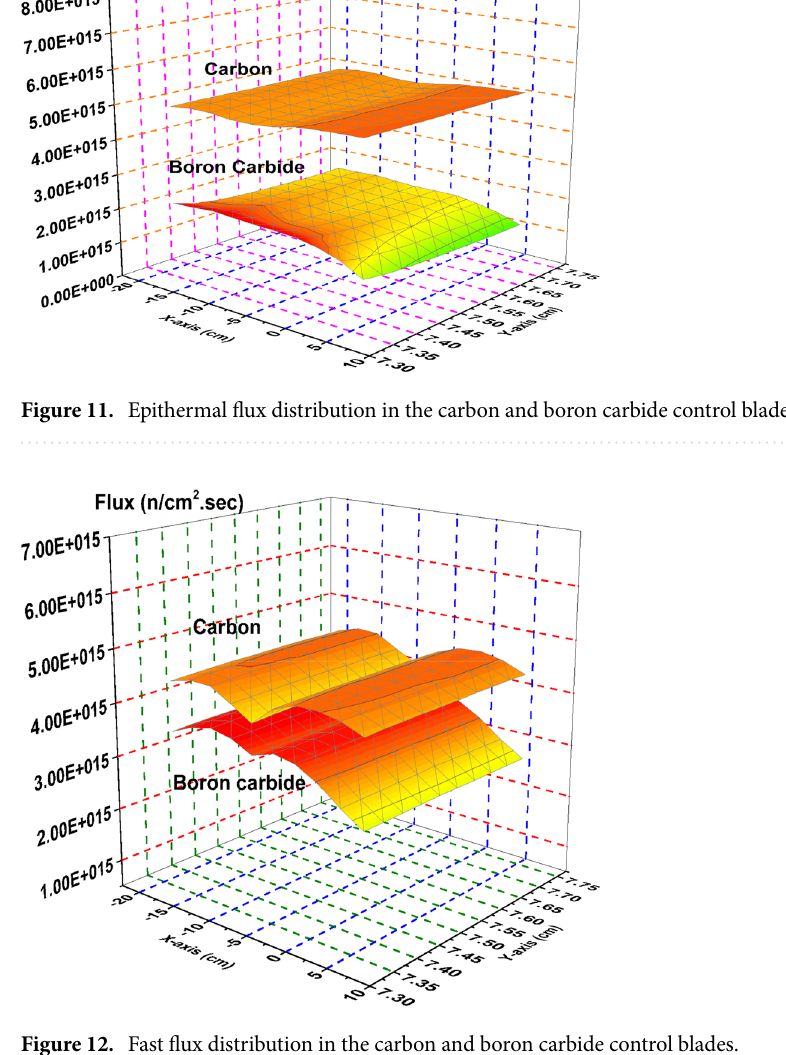
Figure 12. Fast flux distribution in the carbon and boron carbide control blades.